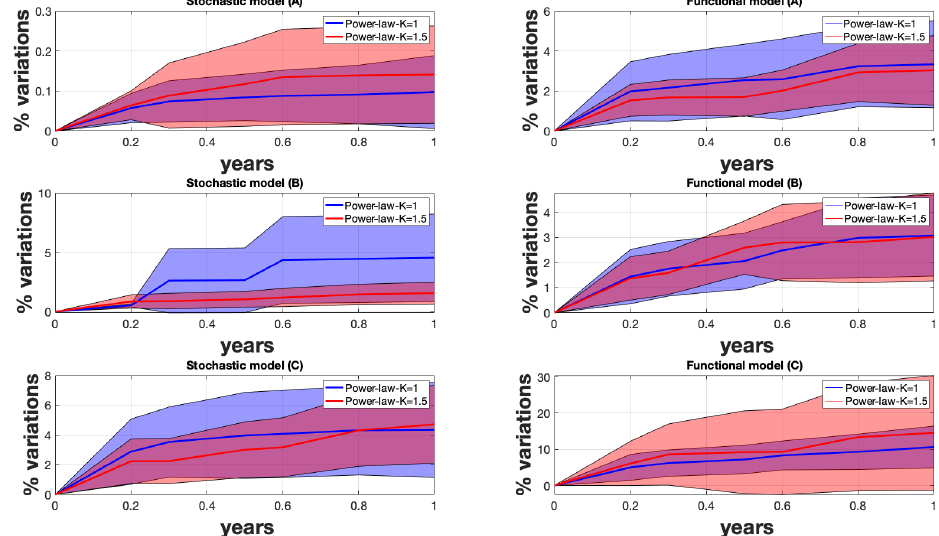
Figure 1. Percentage of variations in the estimated parameters included in the stochastic and functional models when varying the length of the time series. The letters A, B, and C refer to the various scenarios with different coloured noise amplitudes. Table 2. Statistics on the error when fitting the ARMA and FARIMA model to the residual time series following the three scenarios. Error K Case A Case B Case C (mm) b cl < 0 . 1mmyr − K/ 4 1mmyr − K/ 4 > b cl > 0 . 1mmyr − K/ 4 1mmyr − K/ 4 < b cl < 3mmyr − K/ 4 1.0 1 . 44 ± 0 . 01 1 . 74 ± 0 . 01 1 . 89 ± 0 . 04 ARMA 1.5 1 . 46 ± 0 . 01 1 . 76 ± 0 . 04 1 . 95 ± 0 . 05 1.0 1 . 91 ± 0 . 02 1 . 85 ± 0 . 02 1 . 46 ± 0 . 02 FARIMA 1.5 1 . 89 ± 0 . 01 1 . 75 ± 0 . 03 1 . 59 ± 0 .